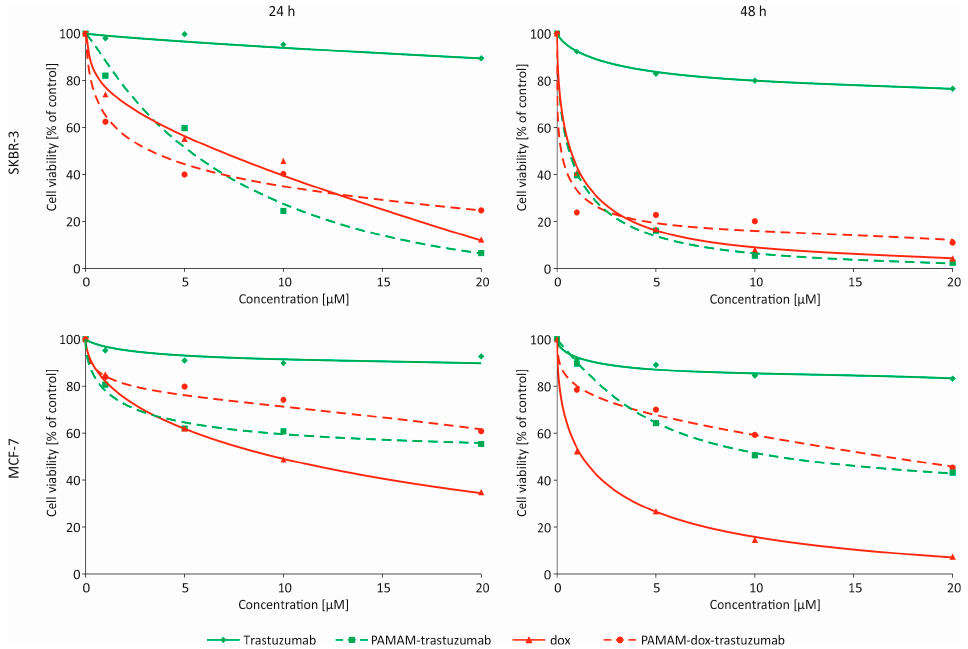
Figure 4. Influence of trastuzumab (green rhombus), doxorubicin (red triangles), PAMAM– trastuzumab (green squares) and PAMAM–dox–trastuzumab (red spheres) conjugates on the viability of MCF-7 and SKBR-3 cells assessed by MTT assay.